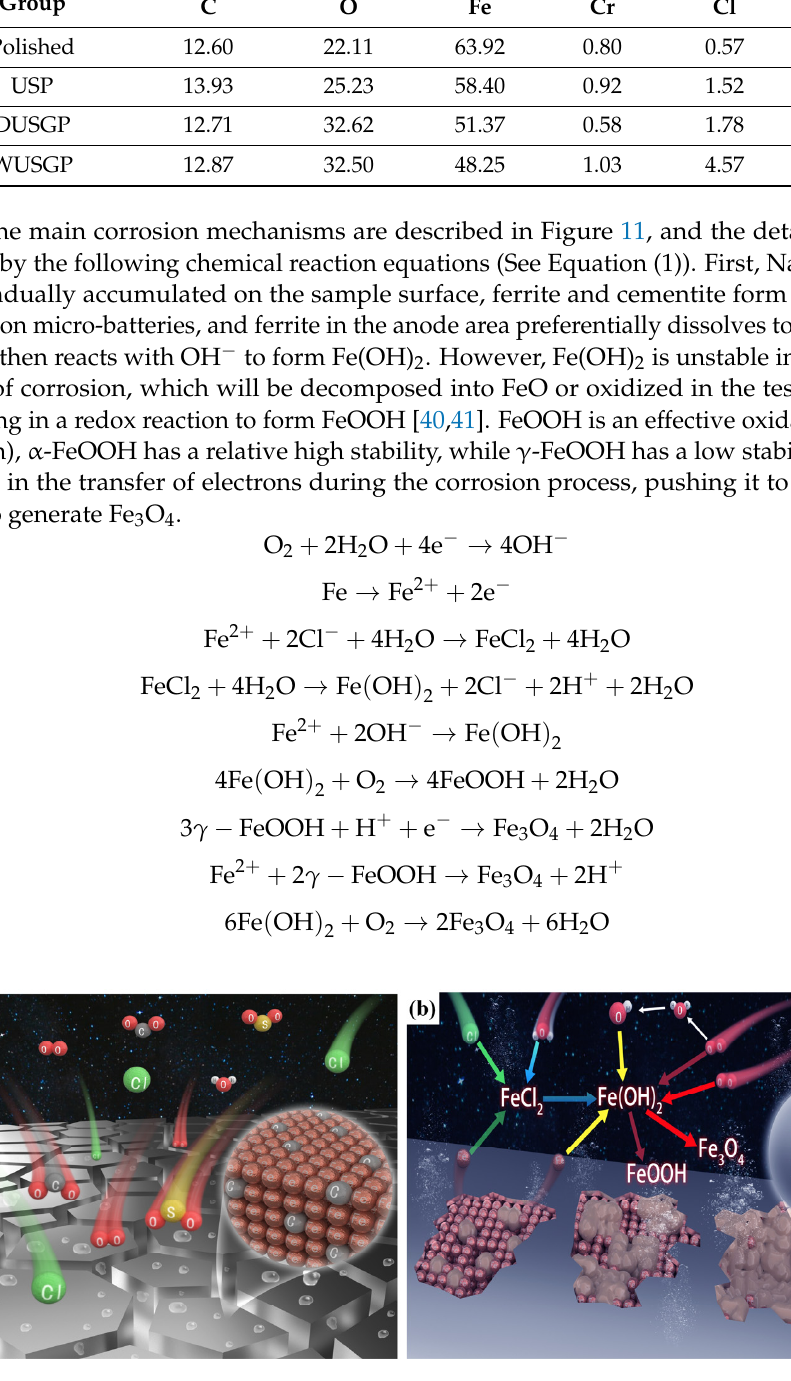
Figure 11. Schematic diagram of salt spray corrosion reaction of samples for initial stage ( a ) and reaction stage ( b ).